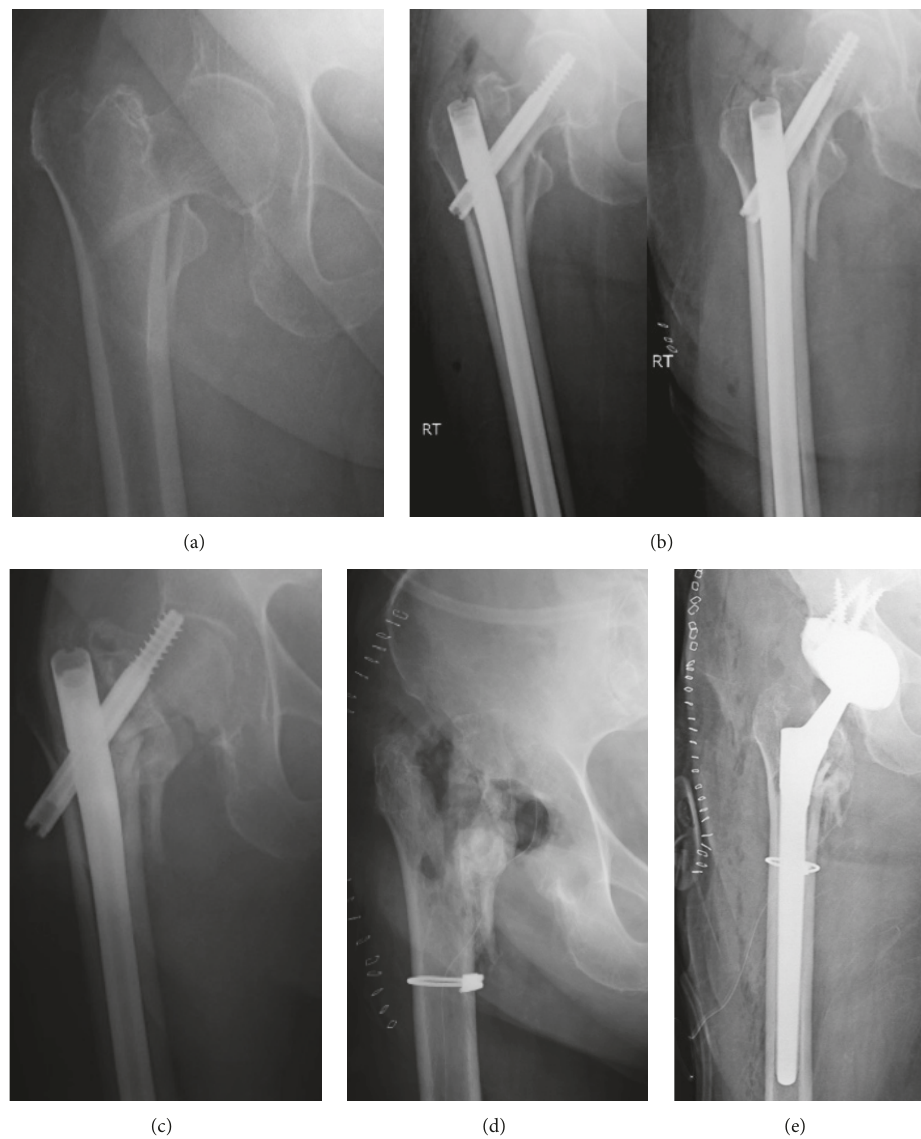
Figure 2: (a) A 85-year-old active female sustained a fall from standing height onto her right hip resulting in an unstable displaced intertrochantericfemur fracture. (b) She underwent locked cephalomedullary nailing within 24 hours of the injury at an outside institution. The neck-shaft angle measures 119 degrees with a 130-degree implant. Note the cranial endpoint for the compression screw. (c) She was referred to an arthroplasty specialist 7 months later with catastrophic failure, screw cutout, and associated acetabular defect. (d) After a long discussion with the patient and her desire for pain relief and ability to ambulate, the decision was made for removal of hardware with femoral head resection and obtainment of cultures. (e) Two days later, cultures were negative for infection, and she was brought back to the operating room for total hip arthroplasty implantation with acetabular augment to correct defect created by the compression screw cutout. A long diaphyseal-fitting stem was used given the poor proximal bone stock, and a cable was placed to support the lateral cortex from lag screw stress riser. The patient is ambulating without pain or assist device 10 months